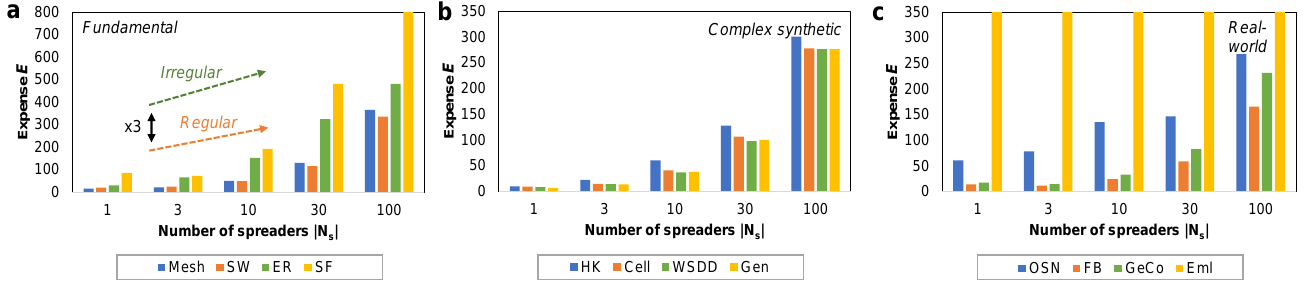
Figure 6. The indoctrination expense E is shown scaling with each topology grouped by the number of spreaders: ( a ) two distinct subcategories of networks are suggested over the fundamental networks— regular ( Mesh and SW with lower expenses) and irregular ( ER and SF with up to × 3 higher expenses); ( b ) complex synthetic networks—similar scaling of E with | N s | for all four networks; ( c ) real-world networks—higher E for the OSN network, and much higher E for the Eml network (in the order of E ≈